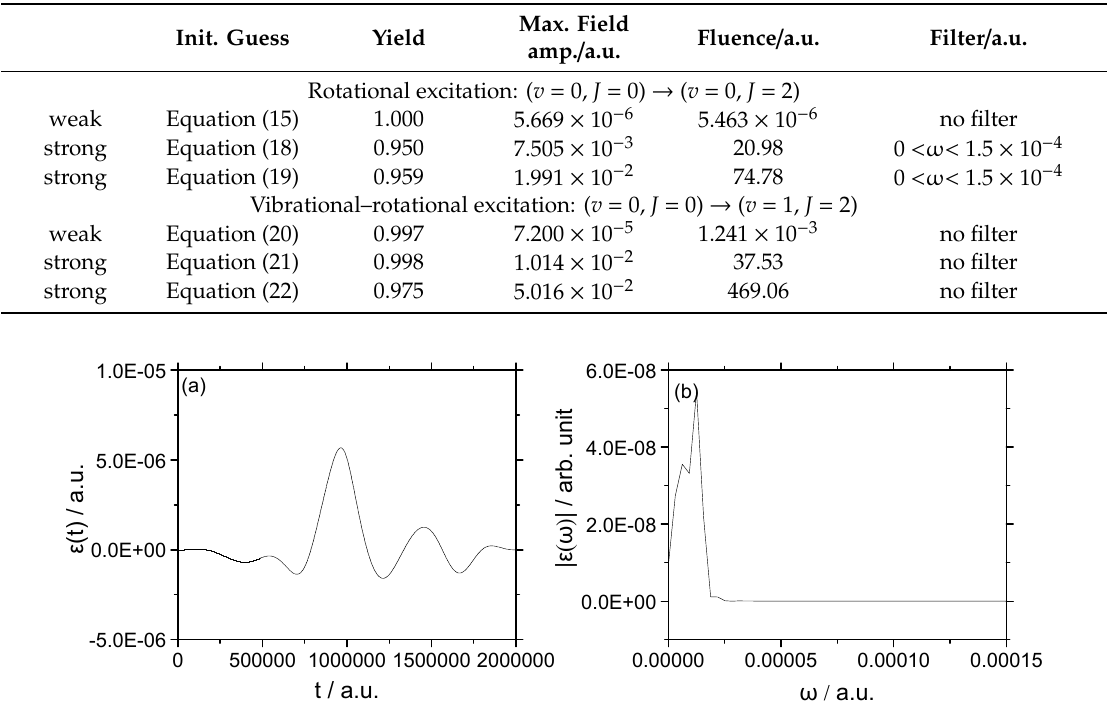
Figure 1. ( a ) The optimal field ε ( t ) for the rotational excitation, ( v = 0, J = 0) → ( v = 0, J = 2) in the weak-field regime; ( b ) the spectrum of ε ( t ).